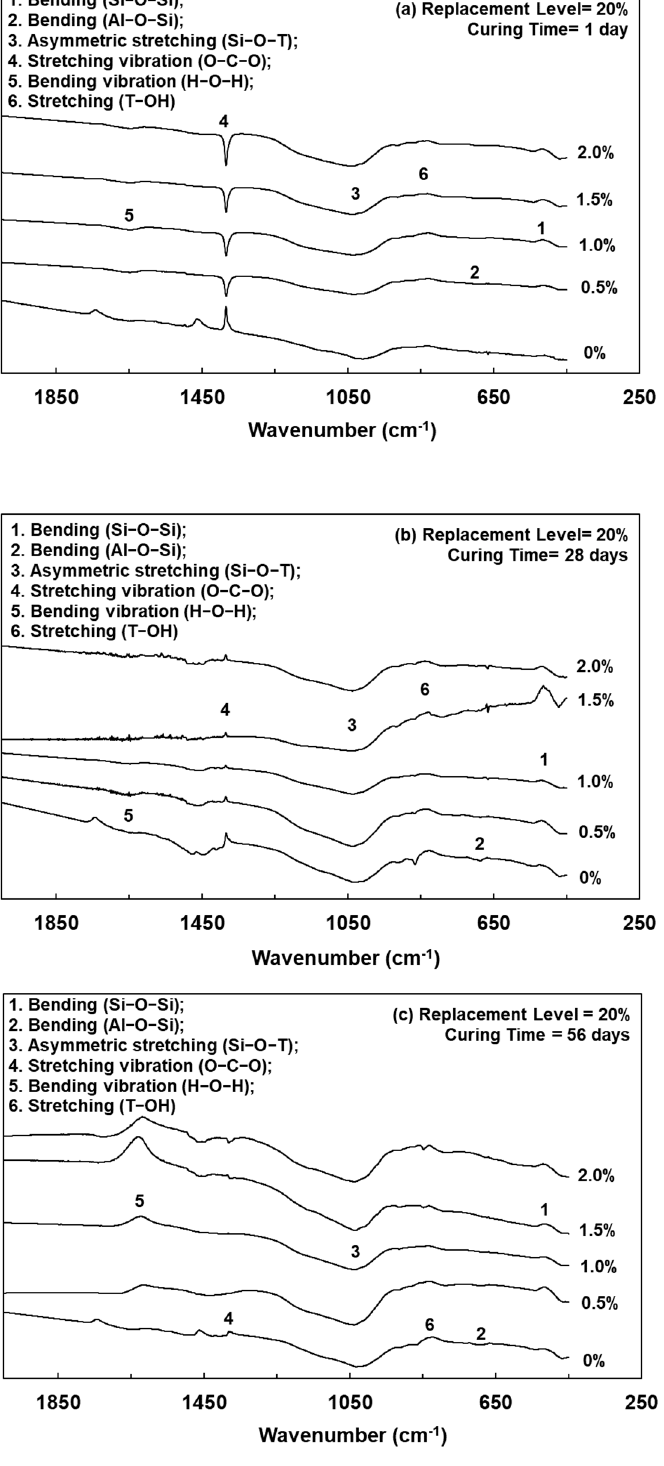
Figure 5. FTIR spectrums of lightweight FGPs. (Replacement level = 20%). ( a ) 1day; ( b ) 28 days and ( c ) 56 days